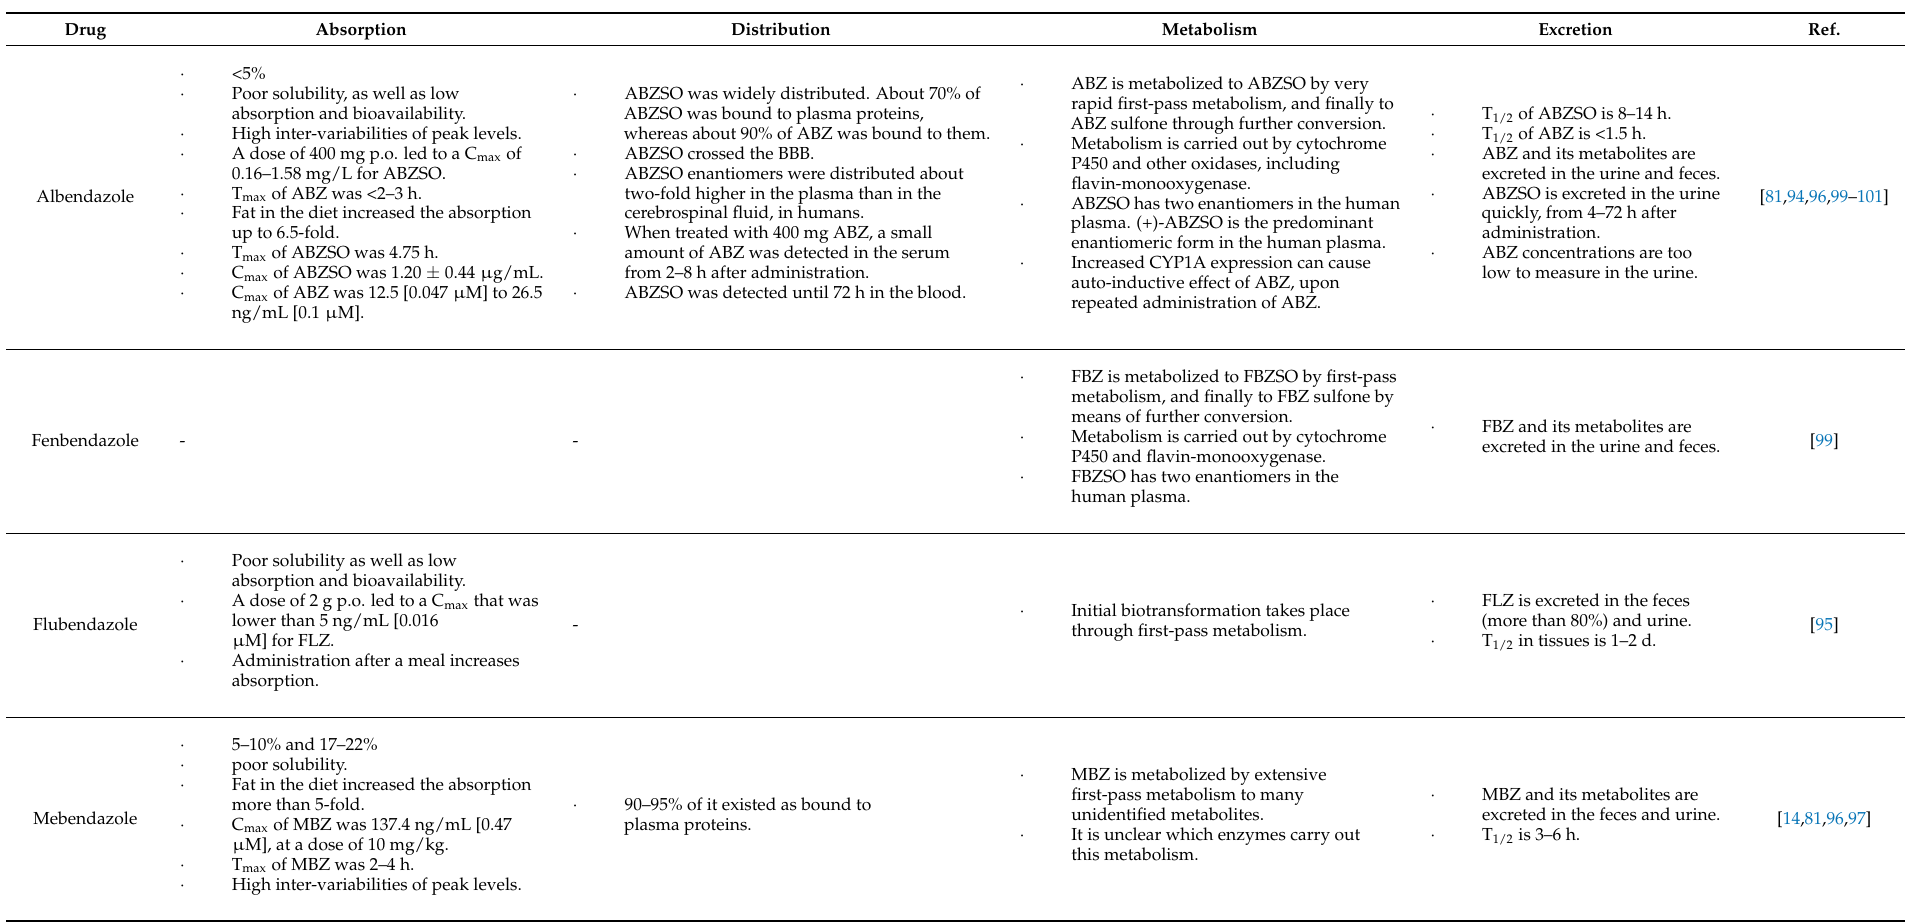
Table 3. Pharmacokinetic Properties of